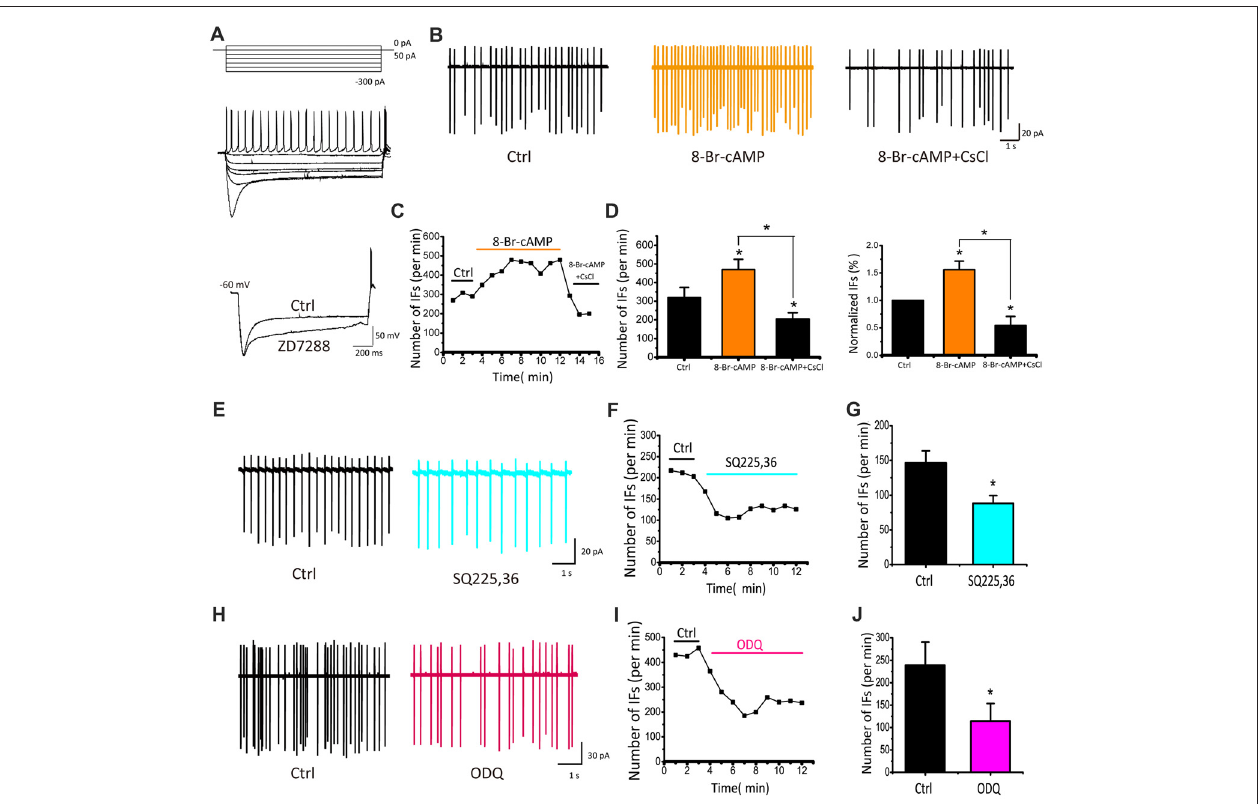
FIGURE 5 | IFs are regulated by cyclic nucleotide in P5–10 CN neurons. (A) Voltage responses produced with 2 s hyperpolarizing pulses from − 300 pA to 0 pA in 50 pA increments showing a depolarizing sag and rebound action potential, both of which are attenuated by ZD7288. (B) Example traces and time course of recording IFs before and after 8-Br-cAMP and CsCl applications. Spike number per minute recording from (B) is plotted against time in (C) . (D) Absolute and normalized rates of IFs for five cells are plotted for 8-Br-cAMP and 8-Br-cAMP+CsCl, respectively. Vertical bars indicate ± SE ∗ p < 0.05. The control solution was applied for 3 min, followed by the bath application of 8-Br-cAMP for 6 min and CsCl application for another 3 min. Data was collected after 2 min drug application to achieve desired concentration. (E–H) Typical recordings of IFs before and during application of inhibitor for the adenylyl cyclase (AC) or guanylyl cyclase (GC), SQ225, 36 (50 µ M) or ODQ (30 µ M), showing that lowering endogenous level of cyclic nucleotides attenuates IFs. (F–I) Time course of representative recordings from neurons shown in (E,H) . The mean rates of IFs for five cells are plotted for SQ225, 36 and ODQ, respectively in (G–J) . Normalized data were collected by taking the average of spikes for each 1 min bin during 6 min drug